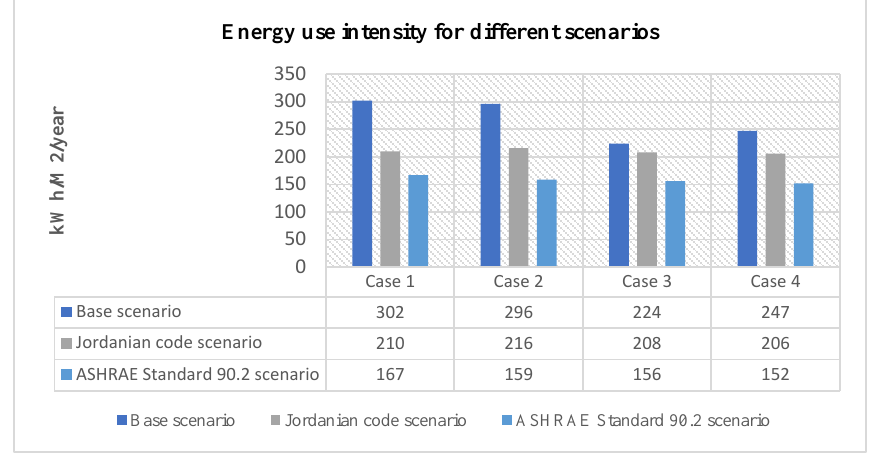
Figure 8. Energy end-use and energy-use intensity after applying the American building energy standard.